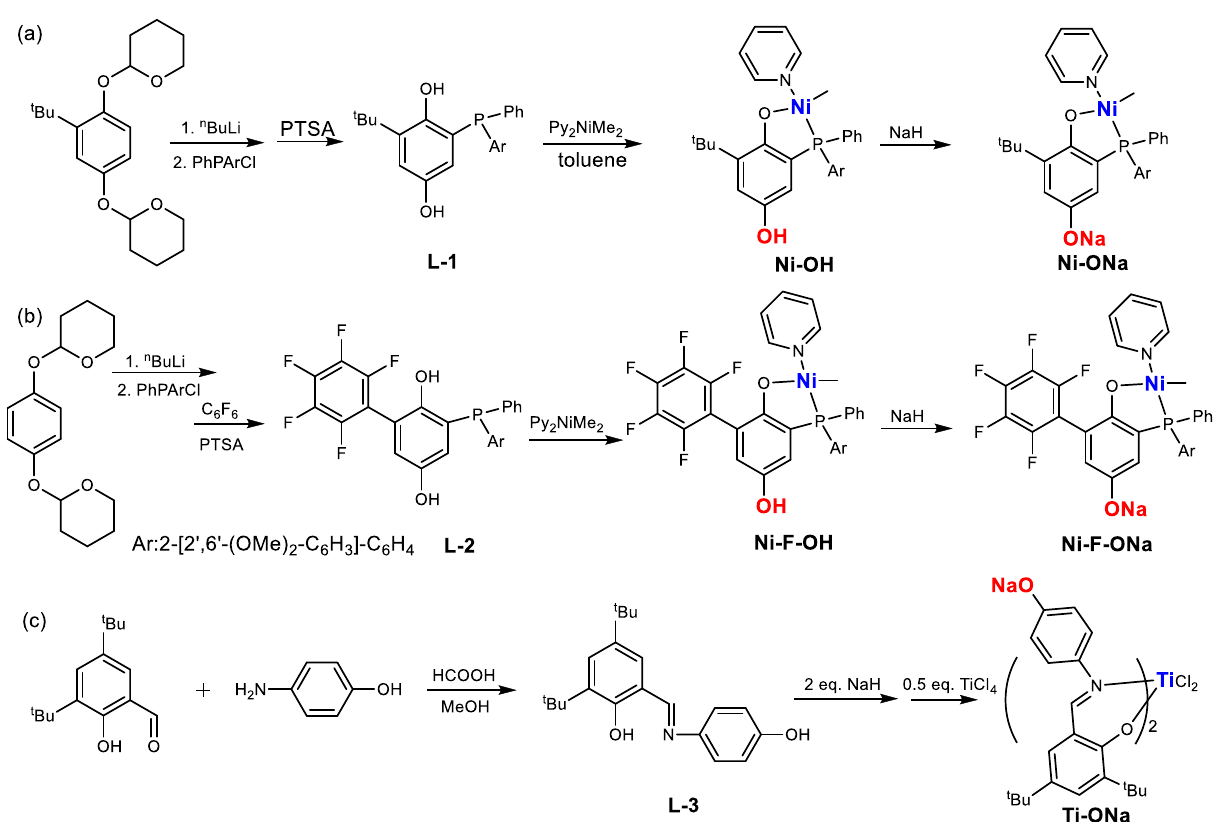
Fig. 2 Synthesis of hydroxyl-functionalized ligands and the corresponding metal complexes. a Phosphinophenolate nickel. b Per fl uorophenyl-substituted phosphinophenolate nickel. c Phenoxy-imine